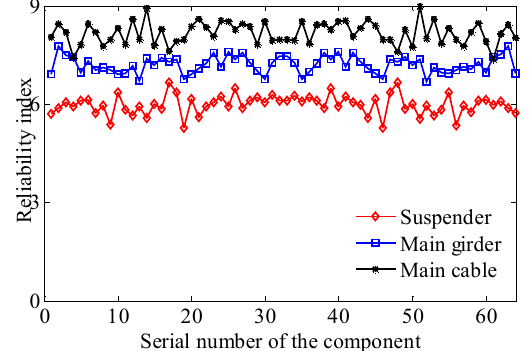
Figure 13. Reliability index of the bridge components.